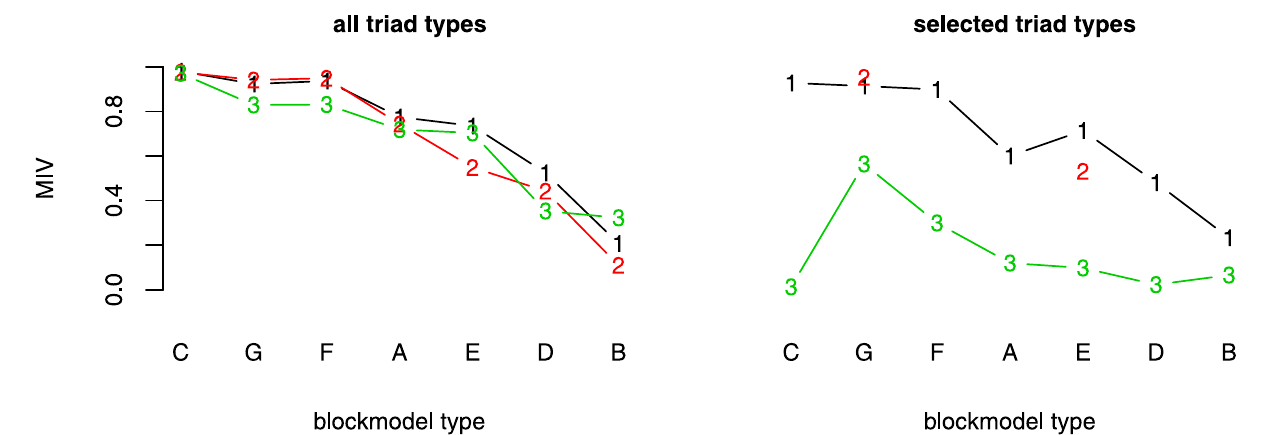
Fig 4. The MIV for each blockmodel type (generated by the RL algorithm) and selected set of triad types. (A) cohesive; (B) symmetric core- periphery; (C) asymmetric core-periphery; (D) hierarchical without complete blocks on the diagonal (E) hierarchical with complete blocks on the diagonal; (F) transitivity without complete blocks on the diagonal; (G) transitivity with complete blocks on the diagonal, (1) allowed and forbidden triad types, (2) allowed triad types, (3) forbidden triad types. Note: only networks of transitivity with complete blocks on the diagonal blockmodel type and hierarchical with complete blocks on the diagonal blockmodel type were generated by considering the selected allowed triad